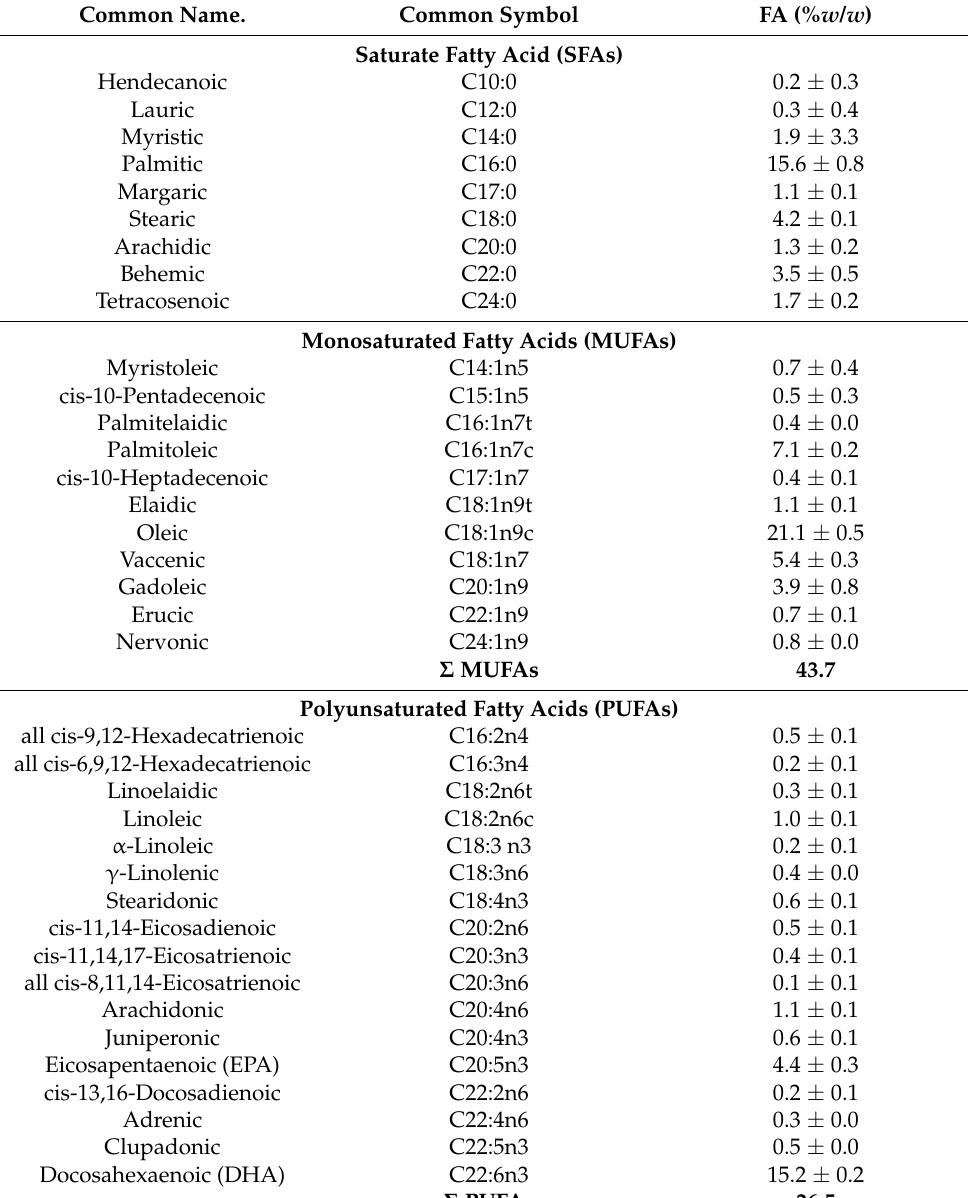
Table 3. Fatty acid profile (%) of monkfish liver oil ( n =